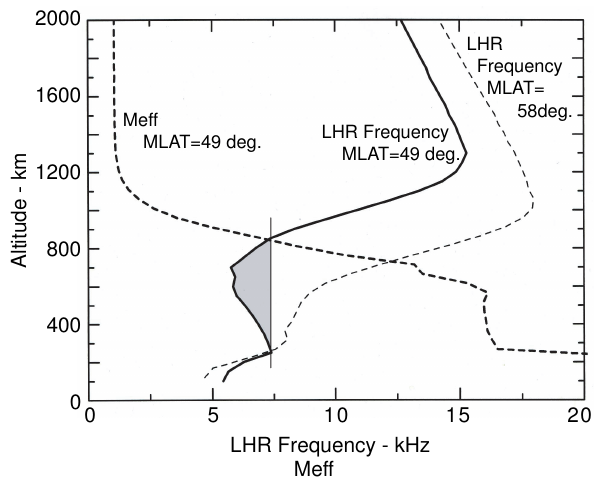
calculated from IRI2001 model. The solid and solid broken lines are LHR frequency and M eff profiles, respectively, corresponding to the geographical and geomagnetic coordination at 01:05:30 UT in Fig. 2. The hatched portion on the LHR frequency profile shows the ionospheric LHR duct. The thin broken line indicates the LHR fre- quency profile at around the ionospheric trough region correspond- ing to 01:02:30 UT in Fig.